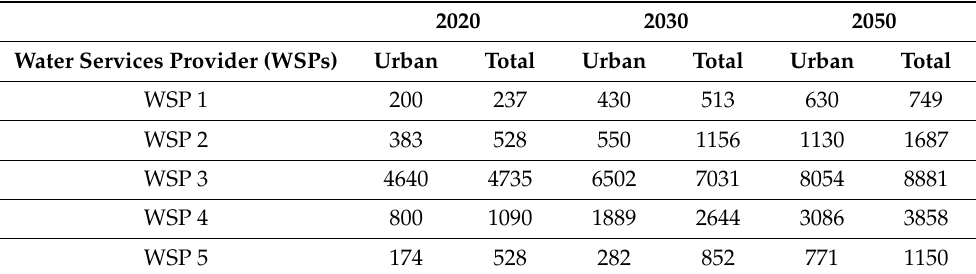
Table 4. Total and urban population ( × 1000) within the service area of the five WSPs for 2020 and the projected years (2030 and 2050) as provided in